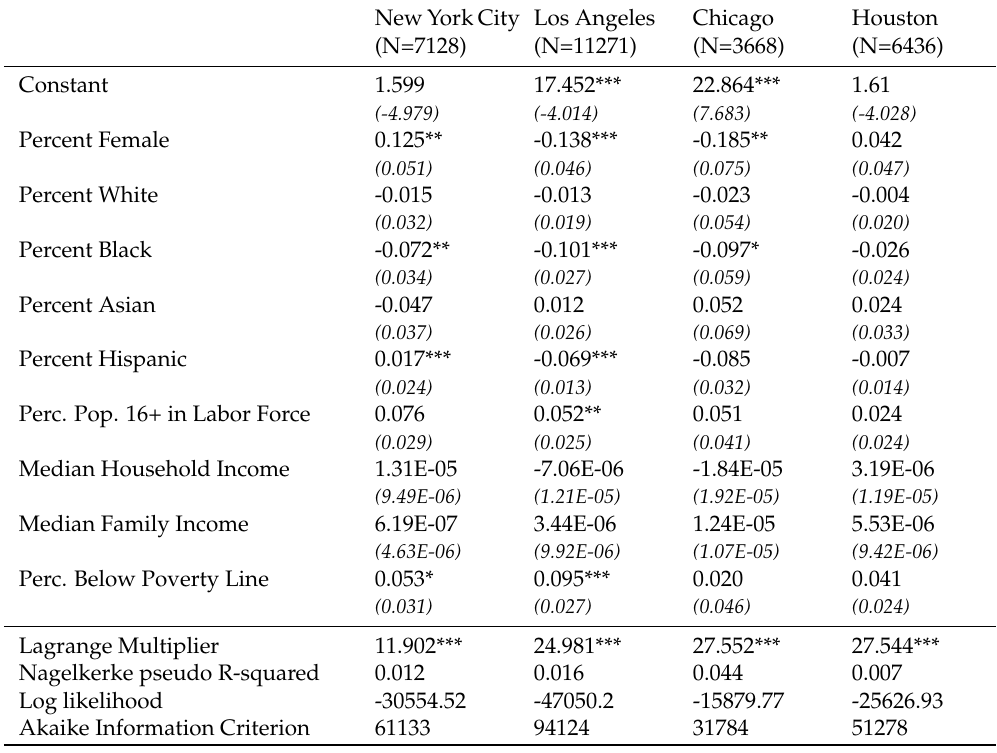
Table 7: Spatial error regression model results for change in visit duration to All POI split by